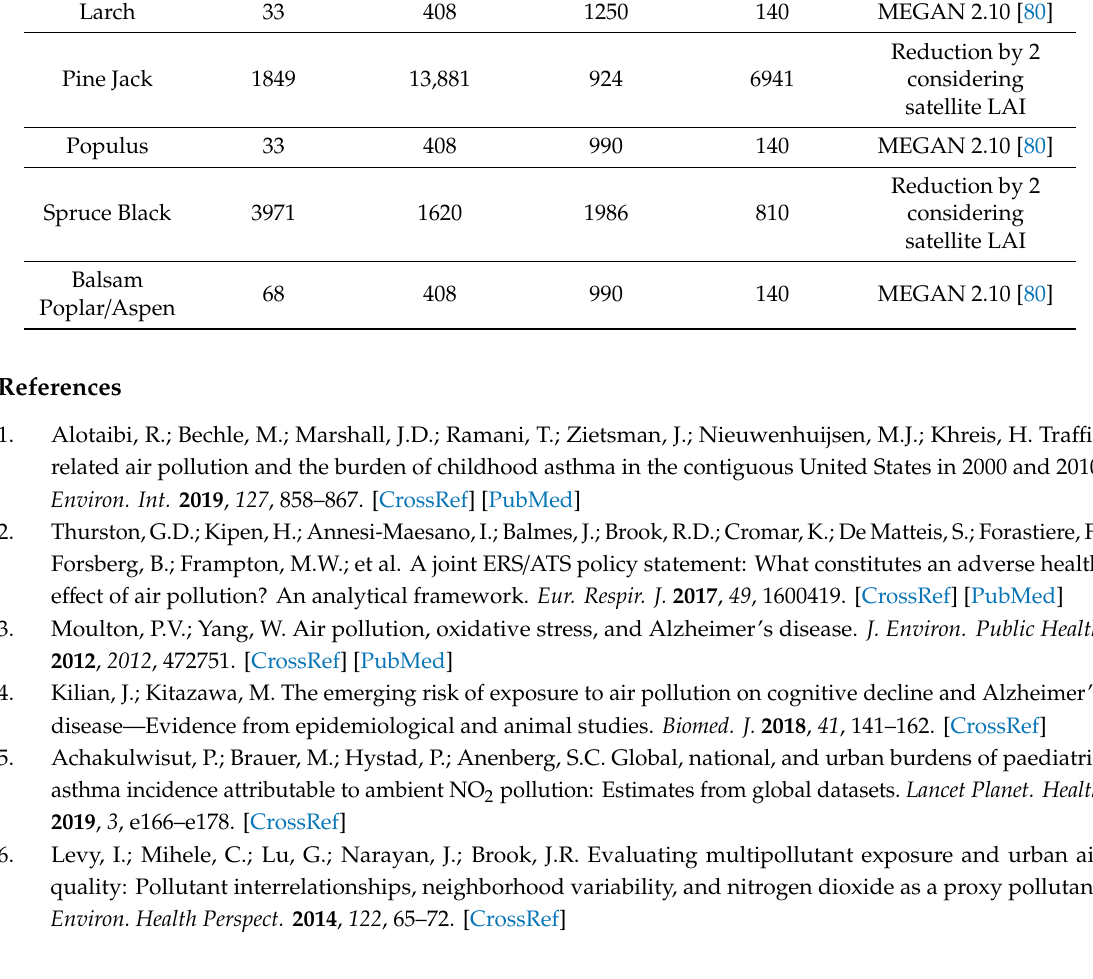
Table A1. Updates to the Biogenic Emissions Inventory System for the Canadian Boreal Forest.